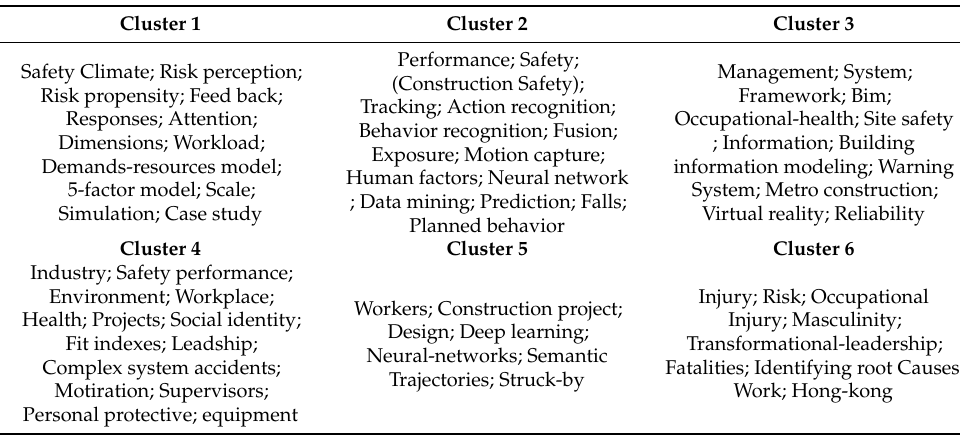
Figure 4. The cluster graph of keyword co word analysis. Table 1. The clustering results of keywords co word